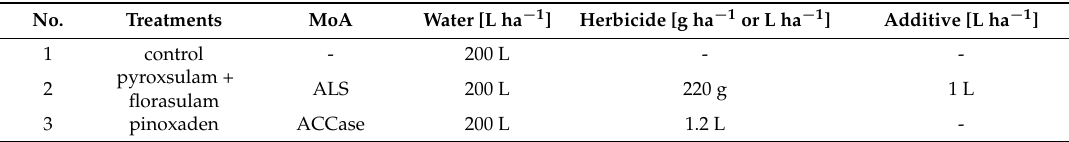
Table 1. Treatment herbicides and dose rates for greenhouse test of Alopecurus myosuroides and Apera spica-venti. Abbreviation: MoA, Mode of Action.